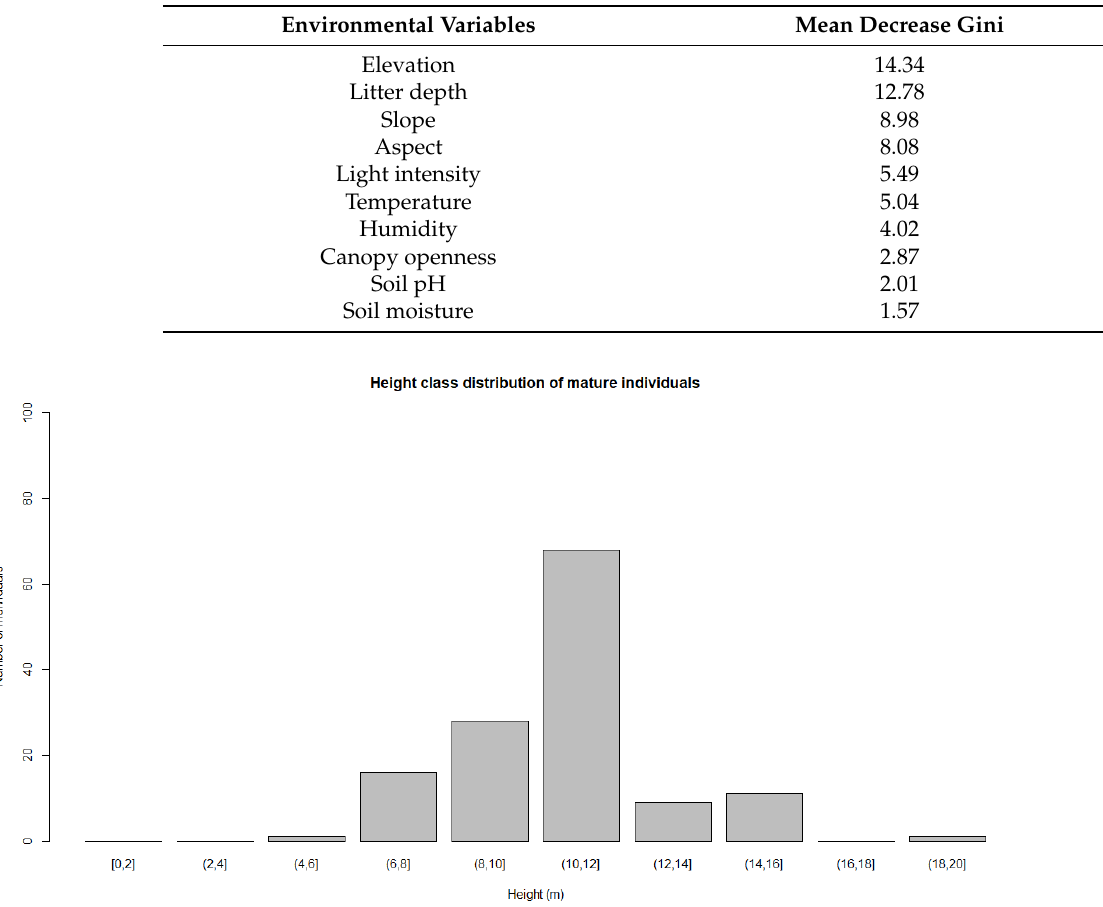
Figure 9. Height class distribution of mature individuals.